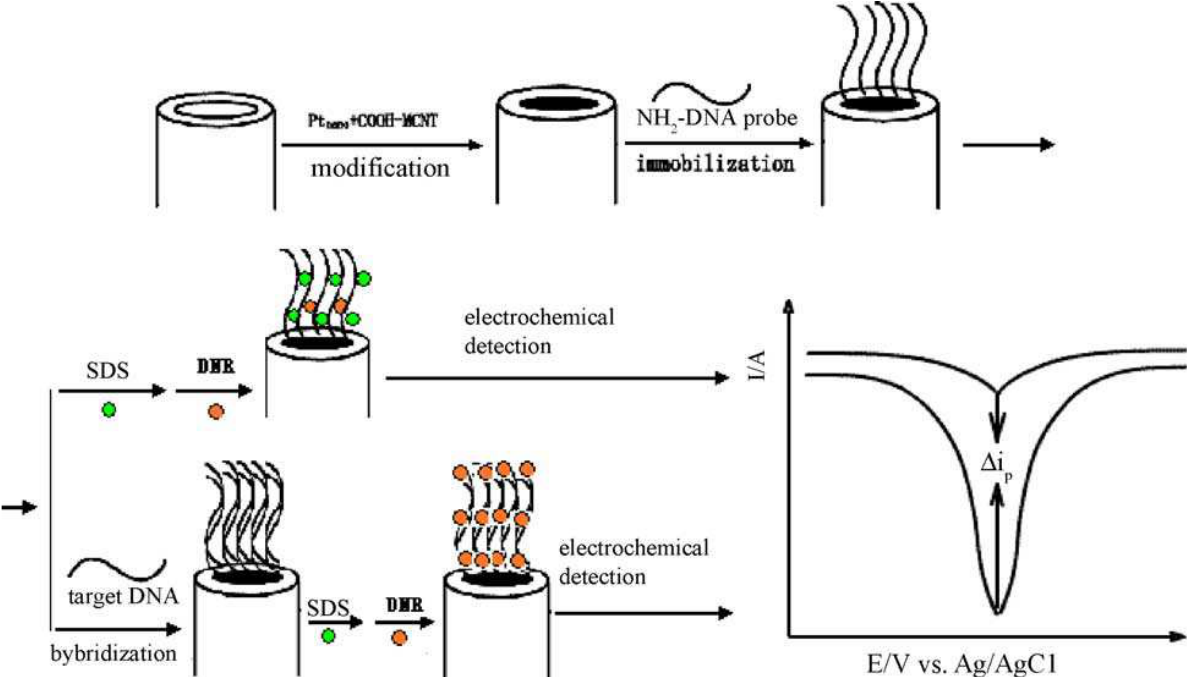
Figure 3. Schematic representation of the electrochemical detection of DNA hybridization based on platinum nanoparticles combined MWCNTs. Reproduced with permission from